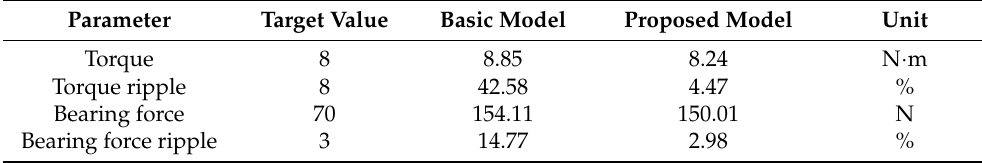
Table 5. Values for the target function of basic and proposed